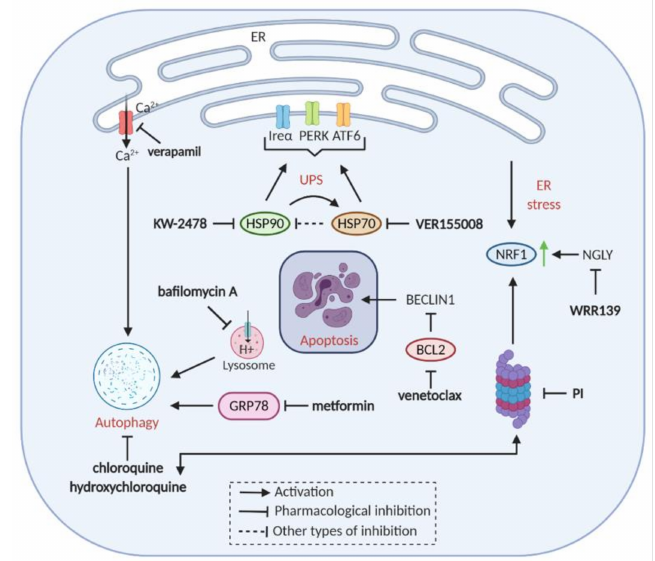
Figure 3. Dual inhibition of cellular stress and proteasome components. Ubiquitin-proteasome system (UPS), endoplasmic reticulum (ER) stress, and autophagy are precisely regulated and con- nected processes. Simultaneous blockage of targets within these pathways and proteasome leads to apoptosis. Proteasome inhibitors (PI) itself induces ER stress, thus targeting ER stress (verapamil, WRR139, KW-2478, and VER15508) in combination with PI leads to increased cellular death. As compensation to proteasome inhibition, cells turn on autophagy. Drugs affecting autophagy (met- formin, bafilomycin A, chloroqouine, hydroxychloroquine) are synthetic lethal with PI. Inhibition of the pro-survival protein BCL2 (venetoclax) leads to increased apoptosis in combination with